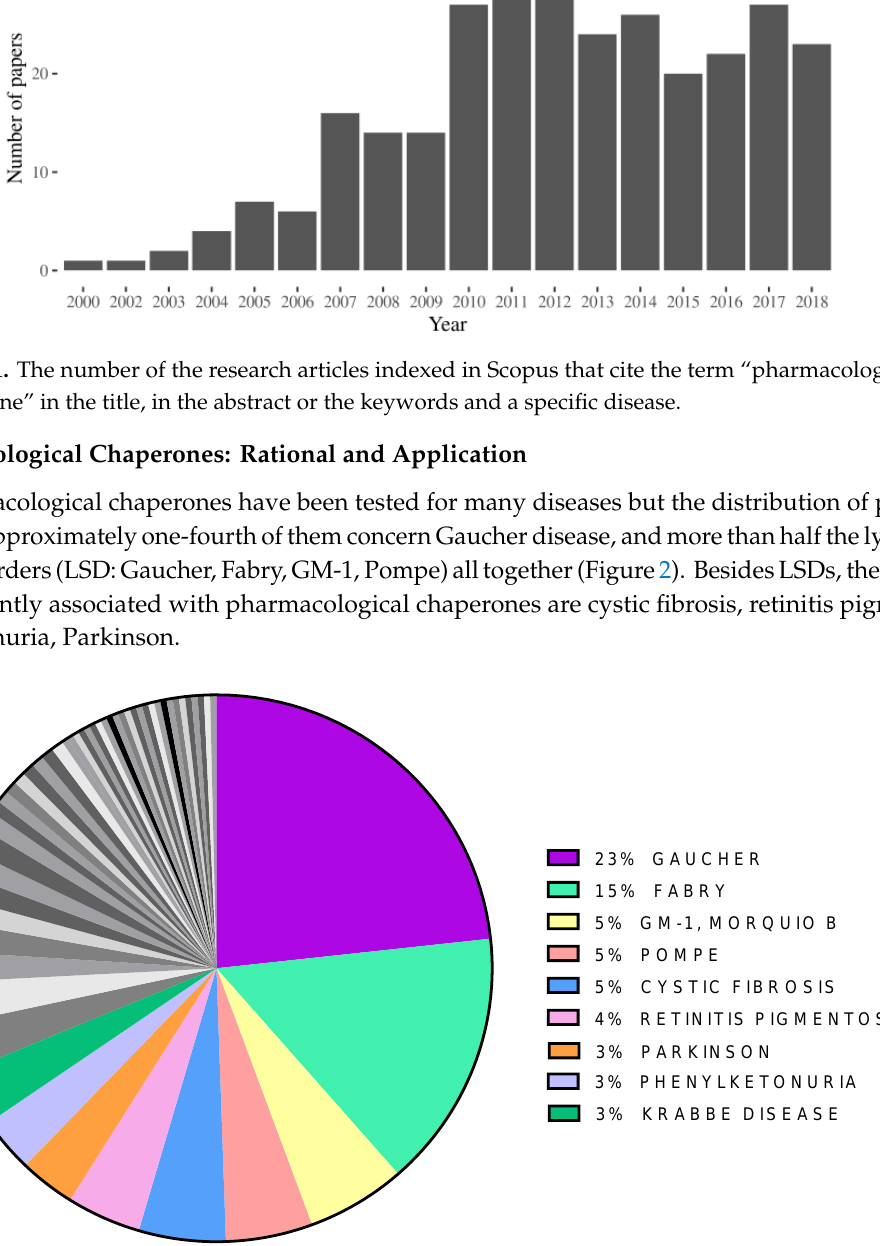
Figure 2. Distribution of papers citing “pharmacological chaperone” per disease. The less represented diseases are in gray.